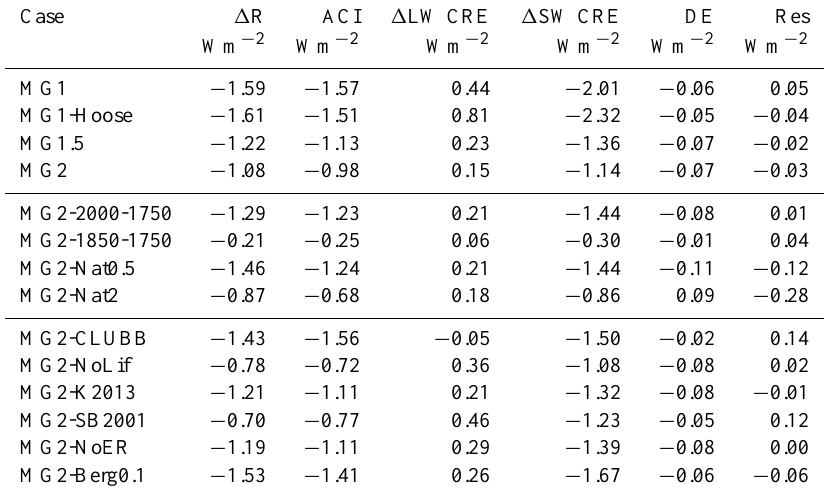
Table 2. Radiative impacts of ACI for the different sensitivity tests. Change in top-of-atmosphere (TOA) flux ( (cid:49) R), ACI as change in clean- sky cloud radiative effect ( (cid:49) CRE), and its long-wave (LW) and shortwave (SW) components following Ghan et al. (2013). Direct effects (DE) of aerosols as described in the text. Finally, a residual (Res = ACI+DE − (cid:49) R). Case (cid:49) R ACI (cid:49) LW CRE (cid:49) SW